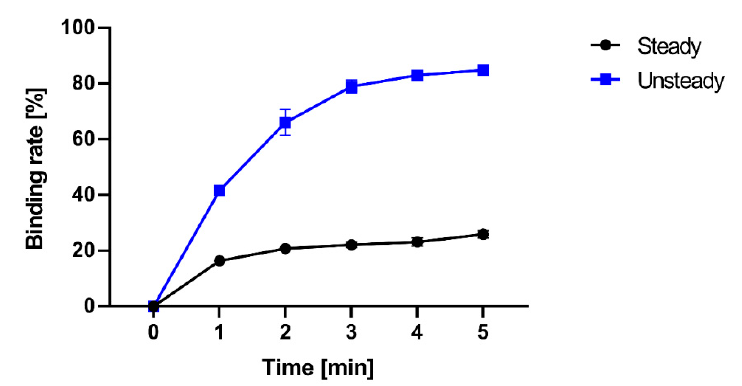
Figure 14. Experimental results on binding rate for various reaction times.